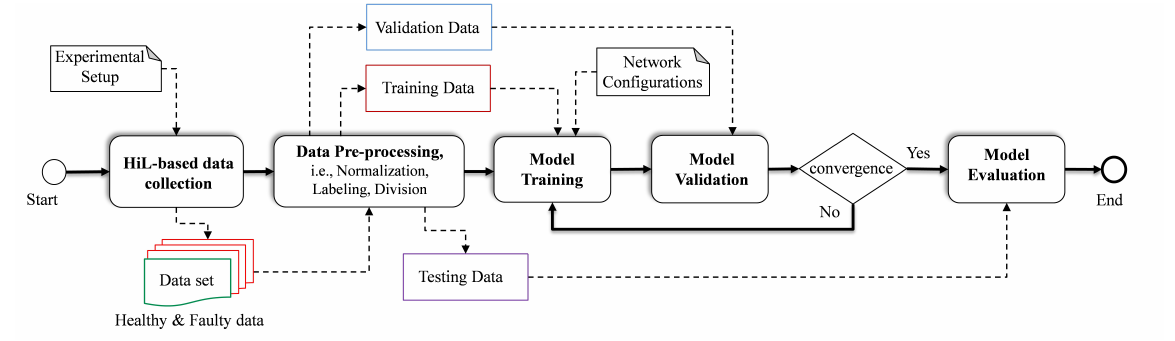
Figure 10. Flowchart of model implementation and optimization.